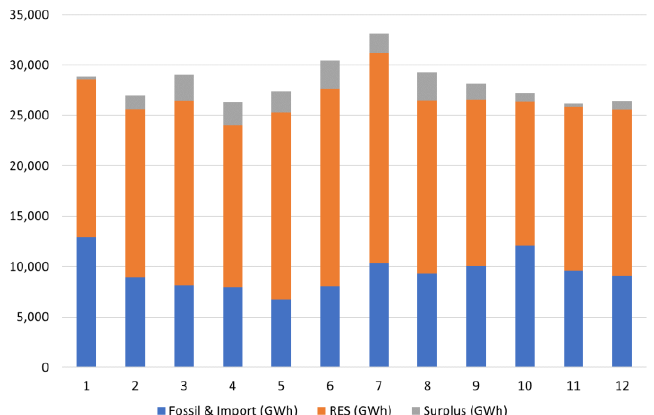
Figure 7. Case 2 with monthly energy production from renewables, from fossil fuel and imports, and renewable energy surplus with four times the production from photovoltaic and thrice the production from wind.